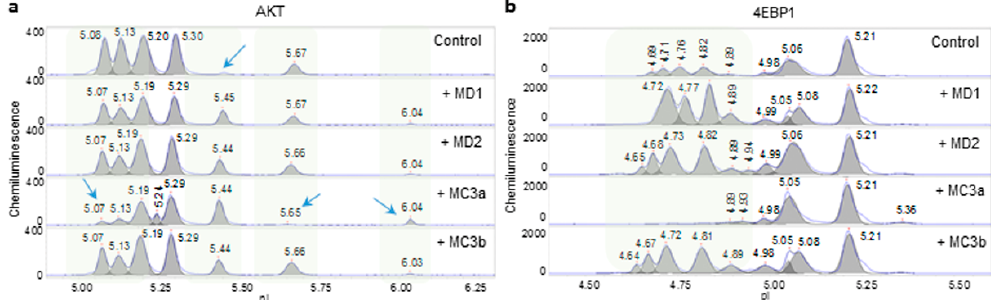
Figure 4. Assessment of the consistency of Melissa essential oils. Levels of phosphorylated Akt ( a ) and 4EBP1 ( b ) isoforms observed following the treatment of HepG2 cells with four Melissa essential oils: MD1, MD2, MC3a, and MC3b. Blue arrows and shaded backgrounds highlight areas where substantial changes in protein isoforms were observed following the treatment of HepG2 cells with Melissa essential oils.